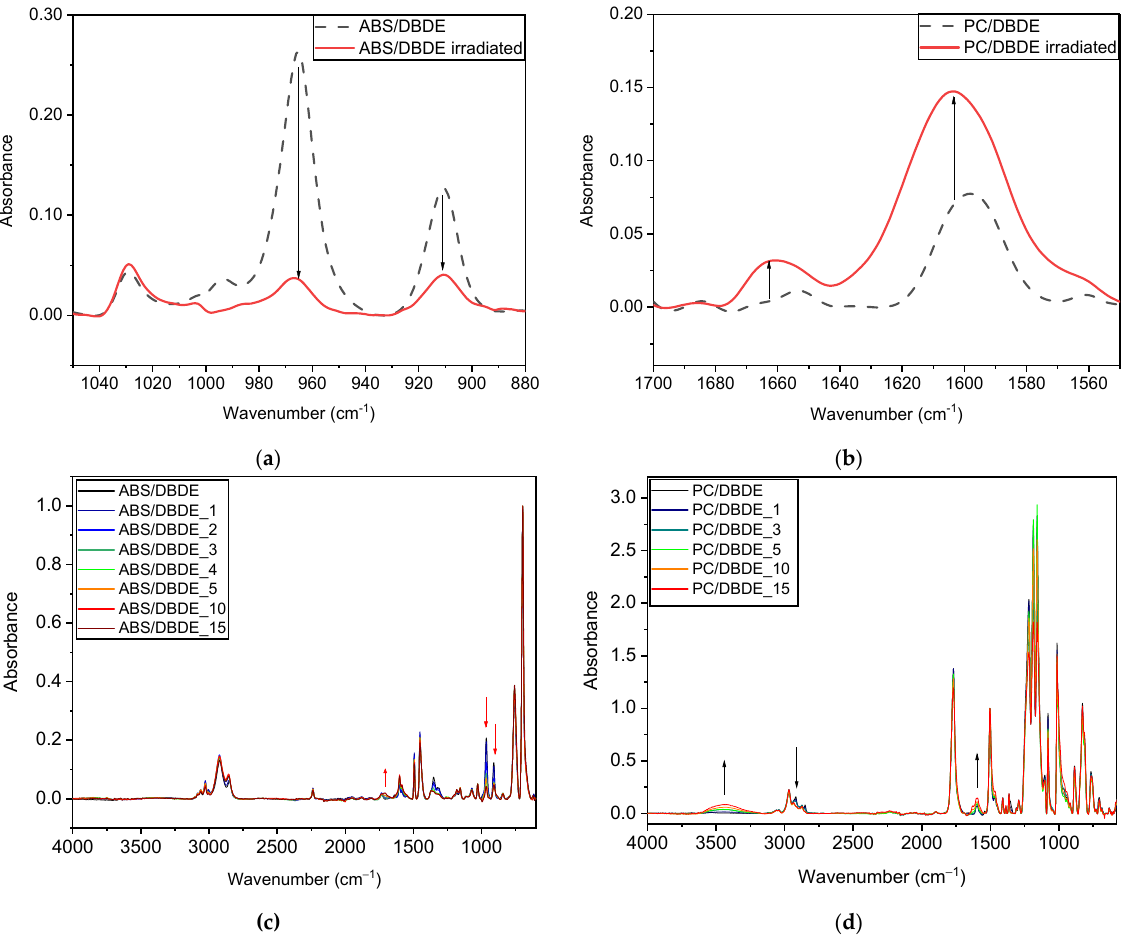
Figure 6. Evidence of surface alteration of irradiated samples in ATR-FTIR spectra ( a ) Decrease in butadiene bands (90 wt-% ABS/10 wt-% DBDE film); ( b ) Emergence of hydroxybenzophenone bands (90 wt-% PC/10 wt-% DBDE film); ( c ) Evolution of the full spectrum of 90 wt-% ABS/10 wt-% DBDE film with irradiation time given in minutes; ( d ) Evolution of the full spectrum of 90 wt-% PC/10 wt-% DBDE film as function of irradiation time given in minutes.